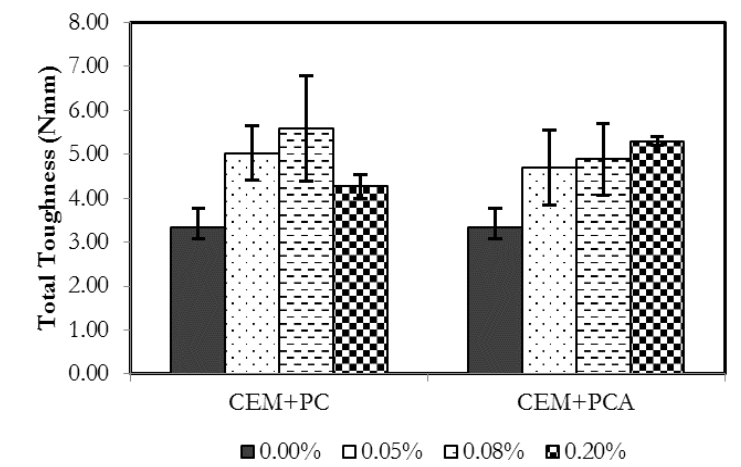
Figure 8: Toughness of the cement composites samples with various amounts of PC & PCA particles inclusions.